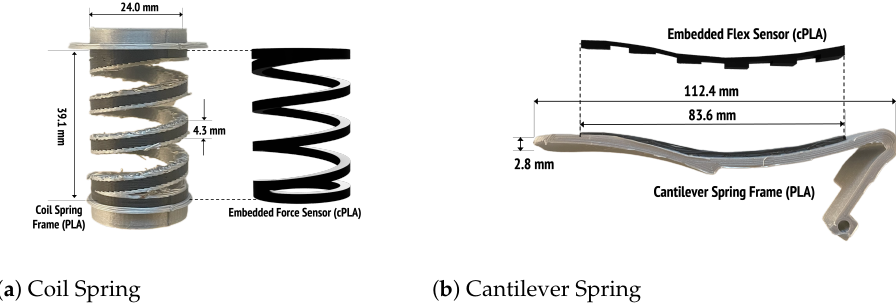
Figure 11. The force-sensing coil ( a ) and cantilever ( b ) springs used in our prosthetic design.